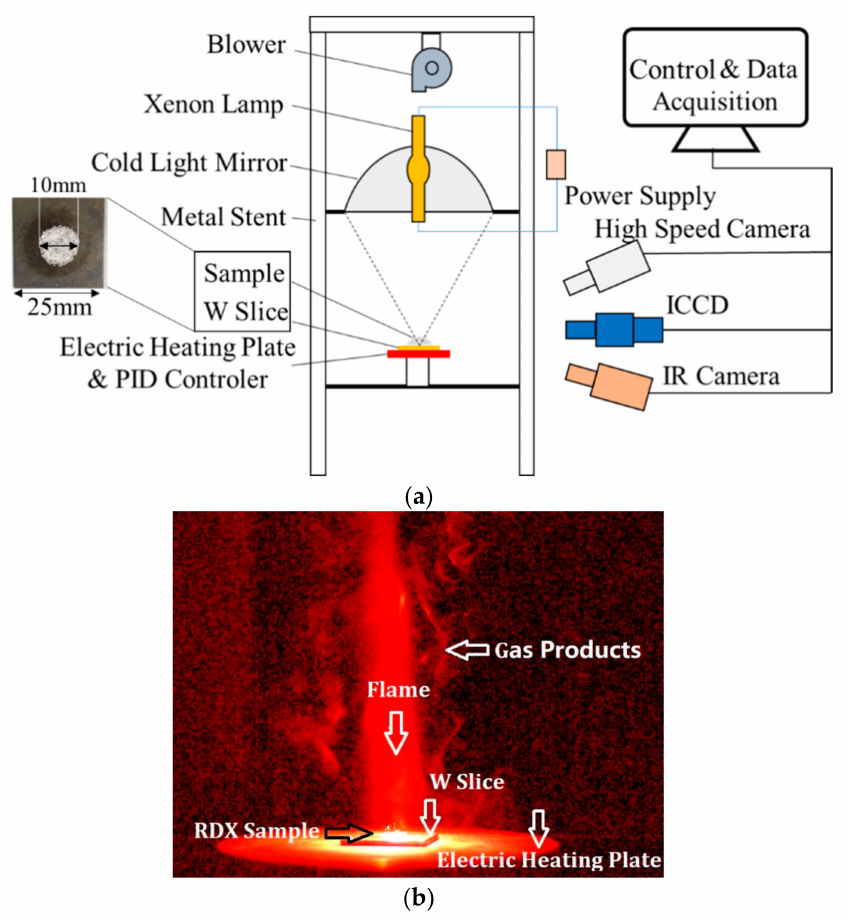
Figure 2. Setup of the experimental system and the flame structure. ( a ) Setup of experimental system; ( b ) Flame structure of